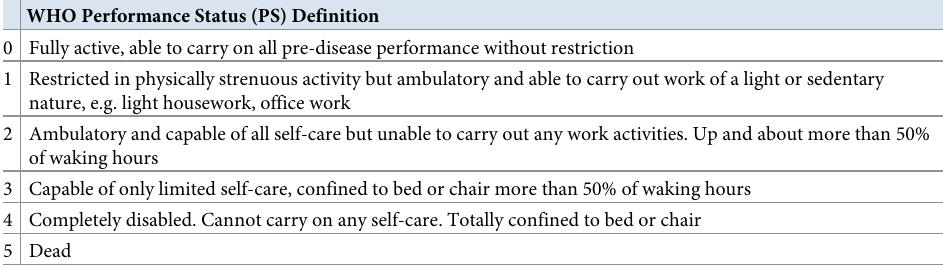
Table 2. WHO Performance Status